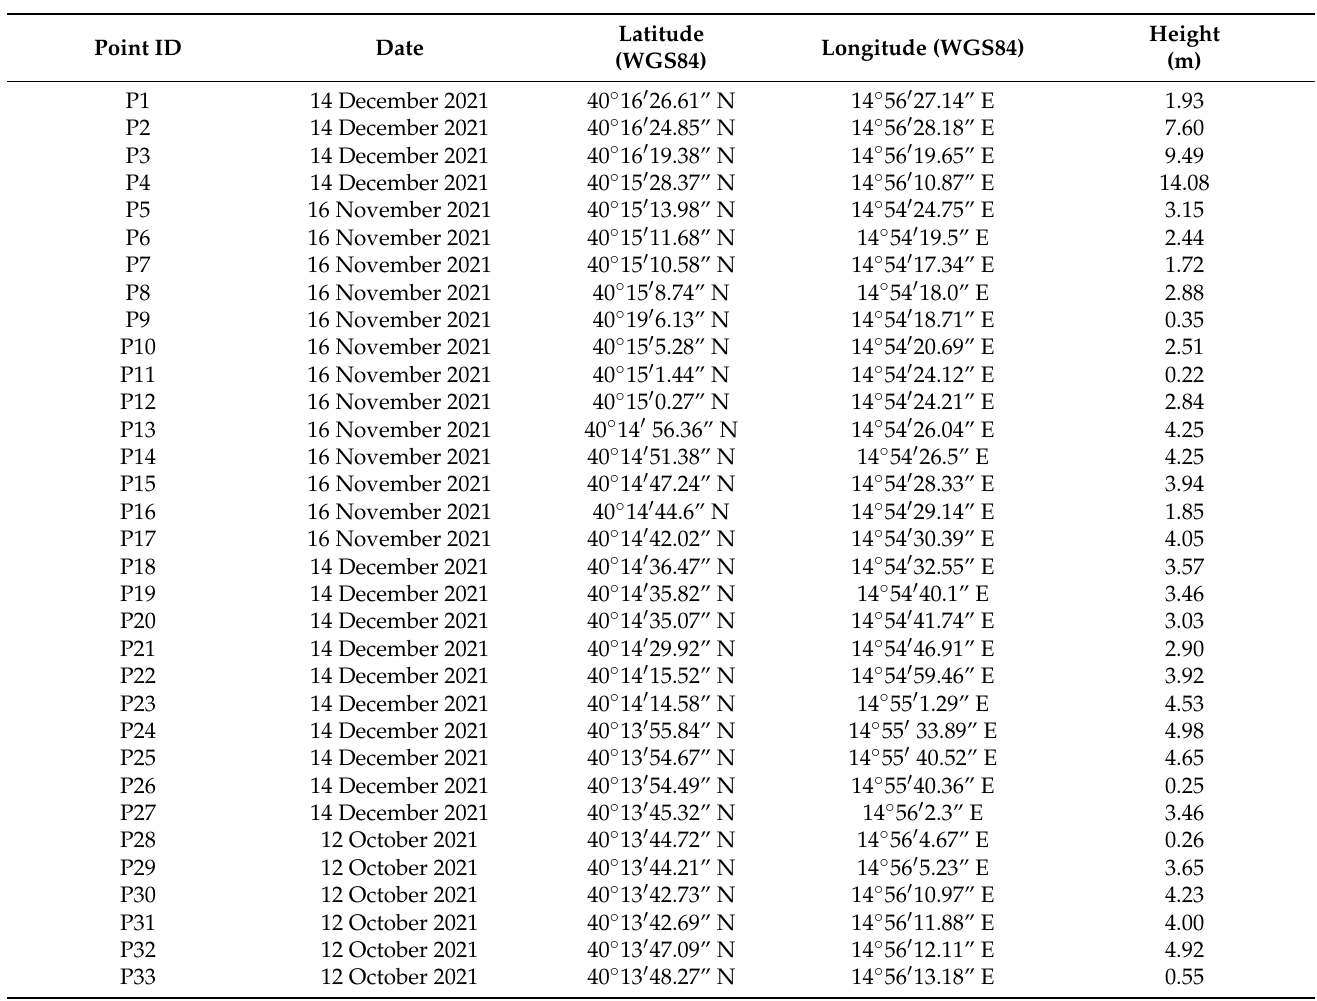
Table 3. GPS measurements obtained along the Punta Licosa